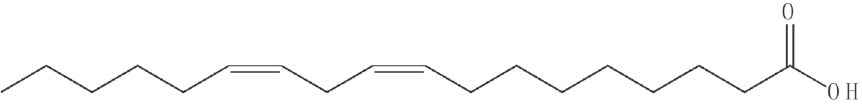
Figure 2. HPLC chromatogram of silica column fraction 3, and nematicidal activity of chromatographic peaks. Top right corner, data presented as nematicidal effects (activity based on movement of C. elegans detected by infrared microbeams) of individual peaks collected from HPLC.